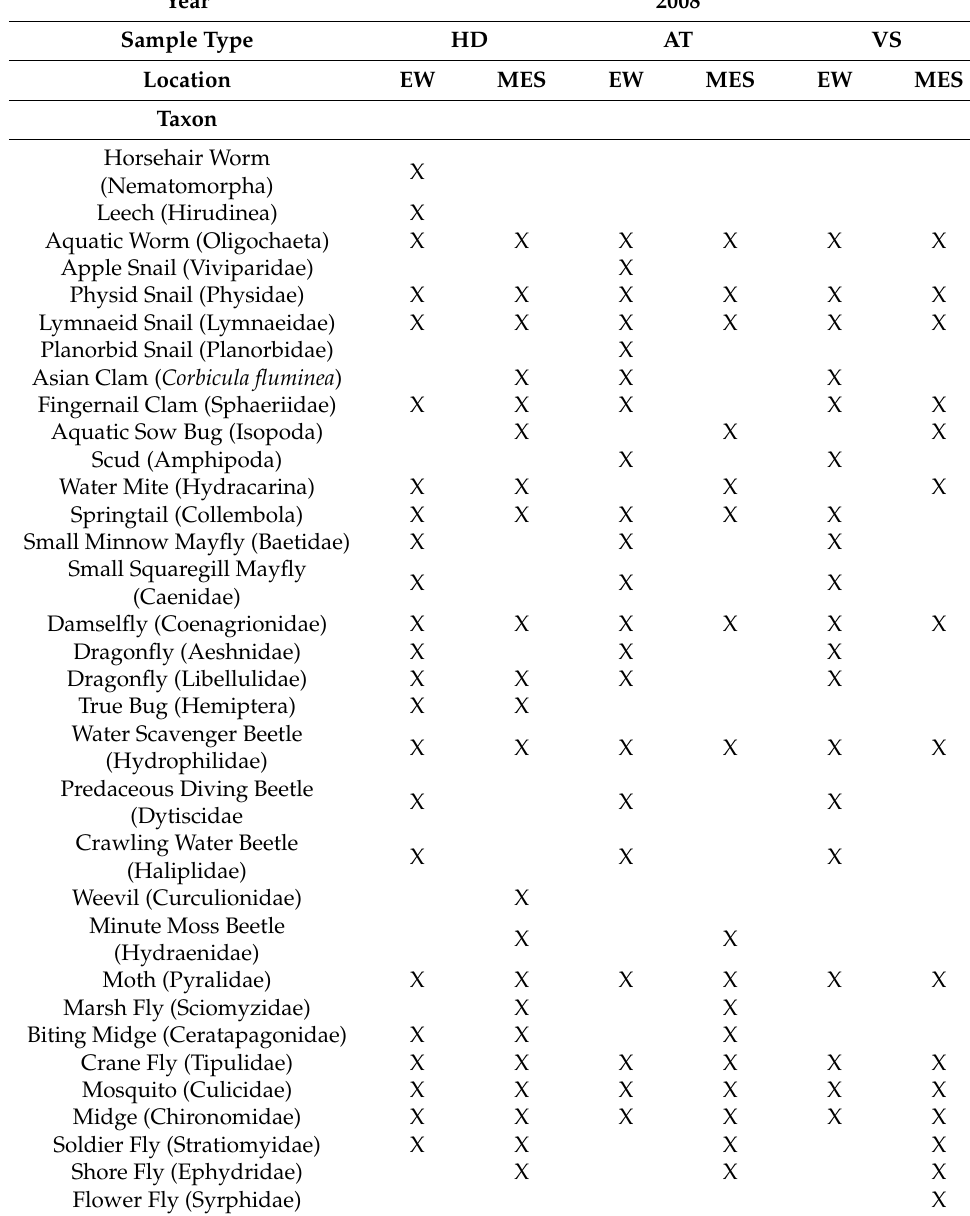
Table 10. Taxa appearing in Hester–Dendy (HD), dip net (mesocosm seed sub-samples), activity trap (AT), and vegetation surface (VS) samples by year and location (EW—experimental wetlands,